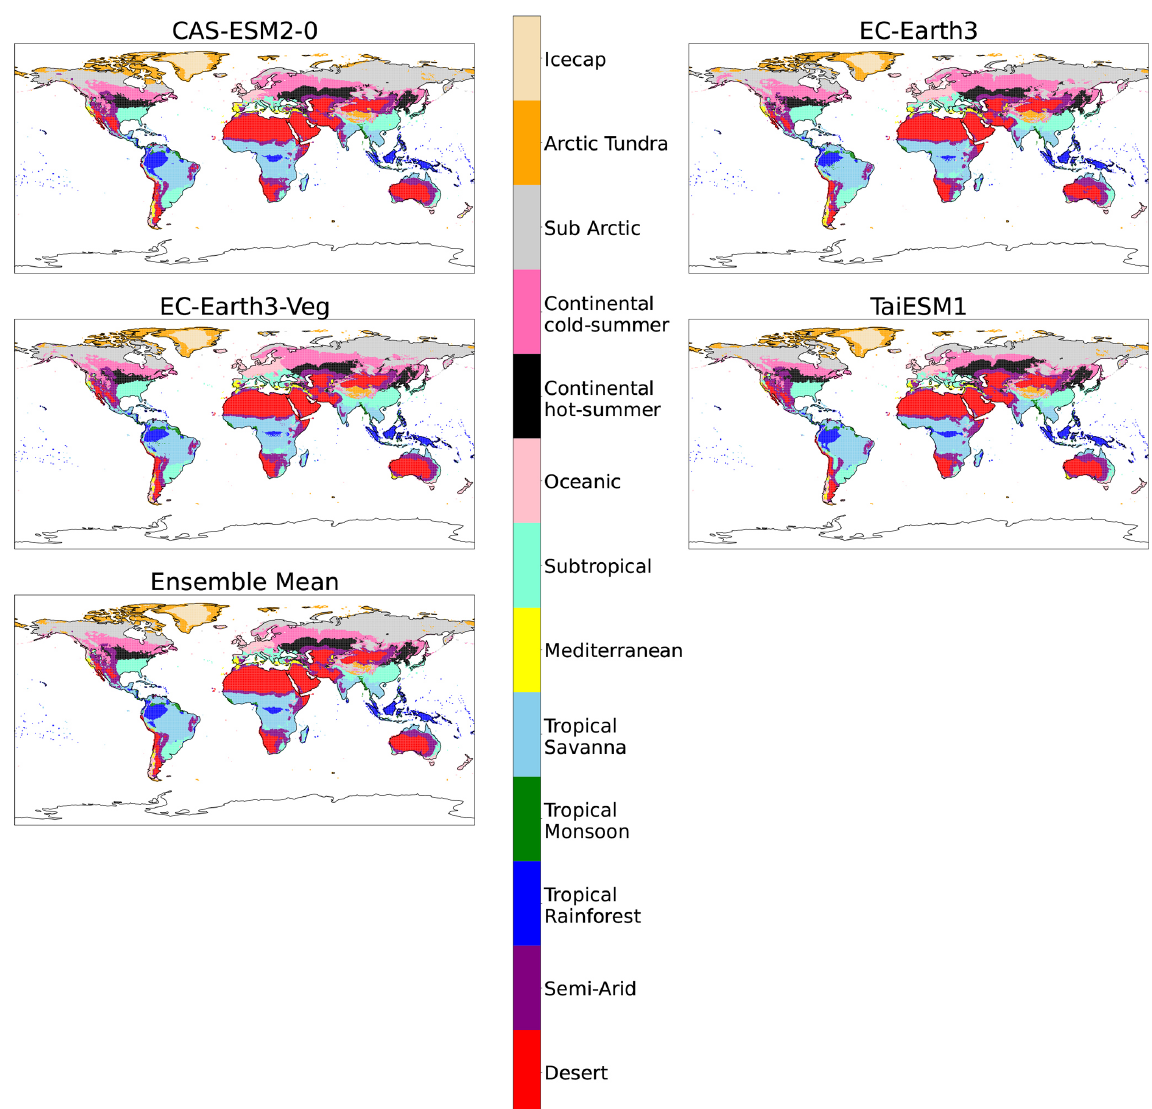
Figure B4. Maps of streamlined KG classifications for each model at + 2K with anomaly